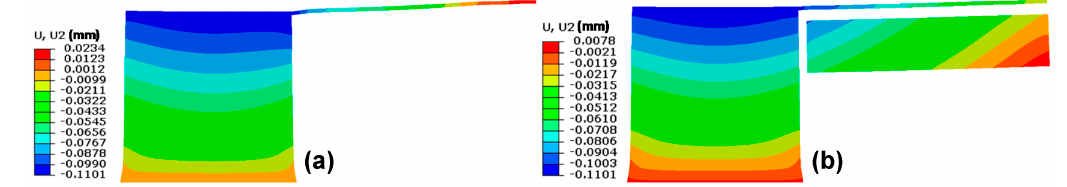
Figure 6. Overhang part deflection (y) examples: ( a ) without support and ( b ) with heat support.